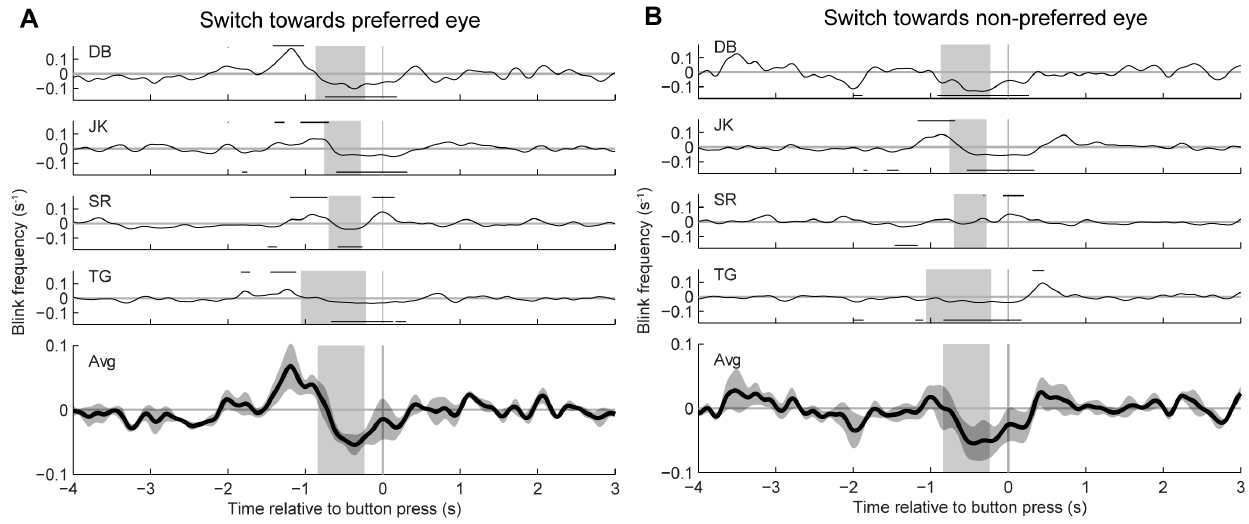
Figure 7. Covariograms of percept switches and blinks. Data are presented in the same way as in Figure 5. A: switches towards the preferred eye. B: switches towards the non-preferred eye. Horizontal lines above and underneath the covariograms indicate significant increases or decreases from baseline, respectively. Note the different scaling of the vertical axis compared with Figure 5 and 6.